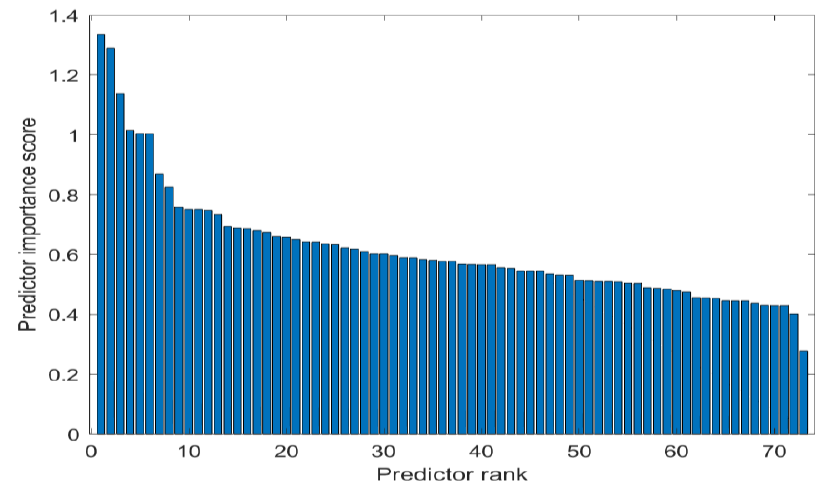
Figure 15. MRMR algorithm.